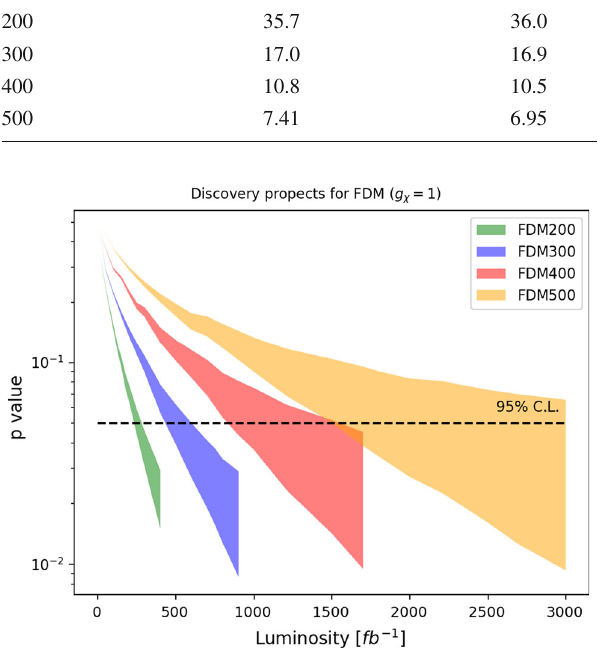
Fig. 10 Discovery prospects of benchmark points with g χ = 1 in FDM model at 100 TeV pp collider. The bands have the same meanings as explained in the caption of Fig. 6